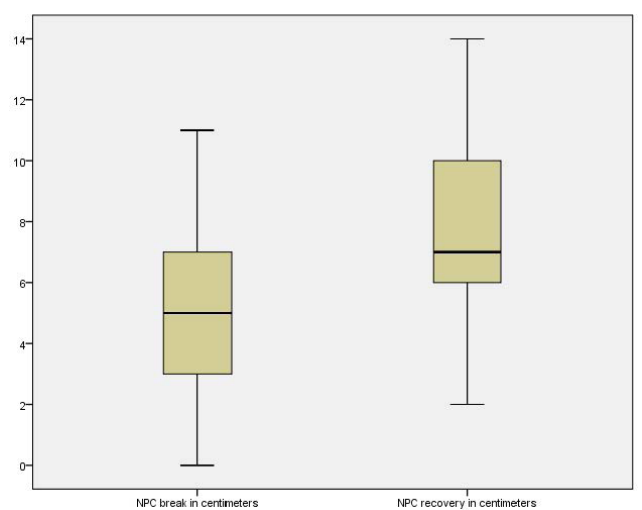
Figure 3 Distribution of convergence